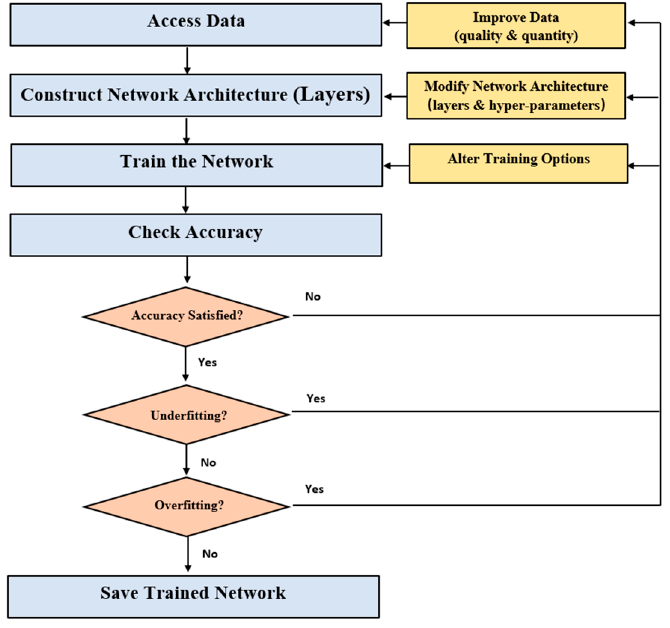
Figure 4. The CNN (convolutional neural network) model development.